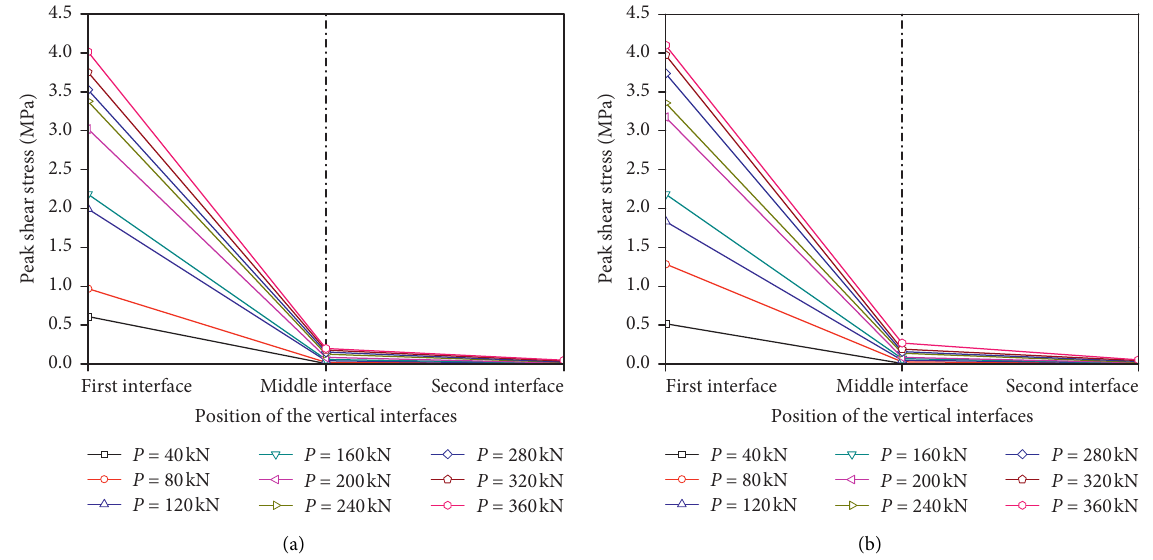
Figure 18: Variation of the value of peak shear stress in three vertical interfaces: (a) G-28-6.5-1 and (b) G-28-4.5-1.